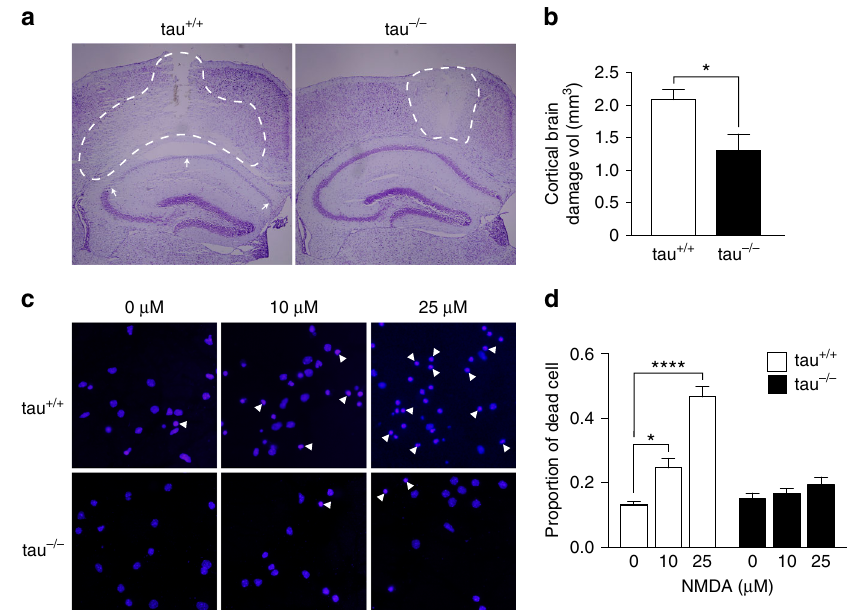
Fig. 5 Tau-depletion reduced neurotoxicity of NMDA. a Representative Nissl staining of tau +/+ and tau − / − brains 24 h after infusion of 0.2 µ l of 50 mM NMDA into the cortex with pale appearance of damaged brain area ( broken lines ). Note that the damaged area extends profoundly into the CA1 region of the hippocampus ( arrows ) in tau +/+ but not tau − / − brains, suggesting progressive expansion of excitotoxicity only in tau +/+ brains. b Quanti fi cation con fi rmed less total brain damage in tau − / − compared to tau +/+ mice (* p < 0.05, N = 4; Student ’ s t -test). c Primary cortical neurons treated with 0, 10 and 25 µ M NMDA showed less cell death (determined by nuclear condensation (some indicated by arrowheads ), DAPI) in tau − / − compared with tau +/+ cells. d Quanti fi cation of neuron death induced by NMDA in tau − / − and tau +/+ cells (* p < 0.05; **** p < 0.0001; N = 12; two-way ANOVA (Sidak post hoc)). All error bars are